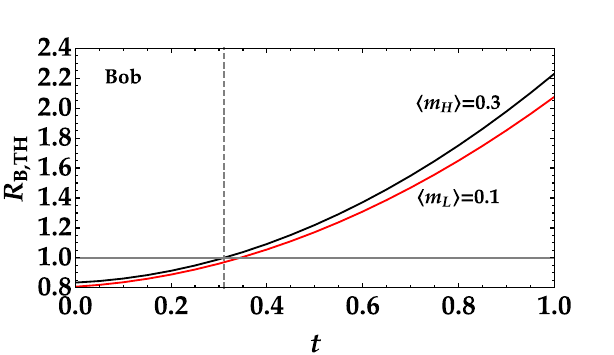
Figure 7. Noise reduction factor measured by Bob as a function of the transmittance efficiency t in the case of the higher mean value (black curve) and of the lower mean value (red curve). The quantum efficiency η is set equal to 0.2, which is the typical value obtained with HPDs. The horizontal gray line at R boundary between classical and nonclassical correlations. The vertical line corresponds to t threshold value over which Bob measures R > 1